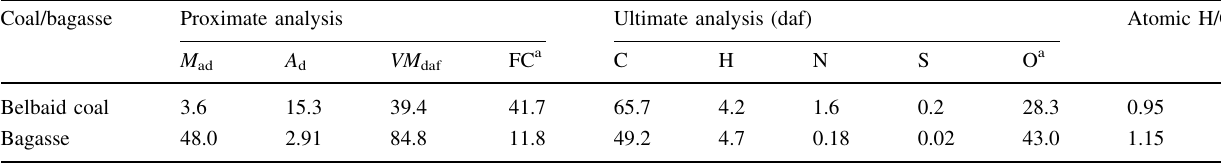
Table 1 Proximate and ultimate analysis (wt%) (on air dried basis) of Belbaid coal and bagasse Coal/bagasse